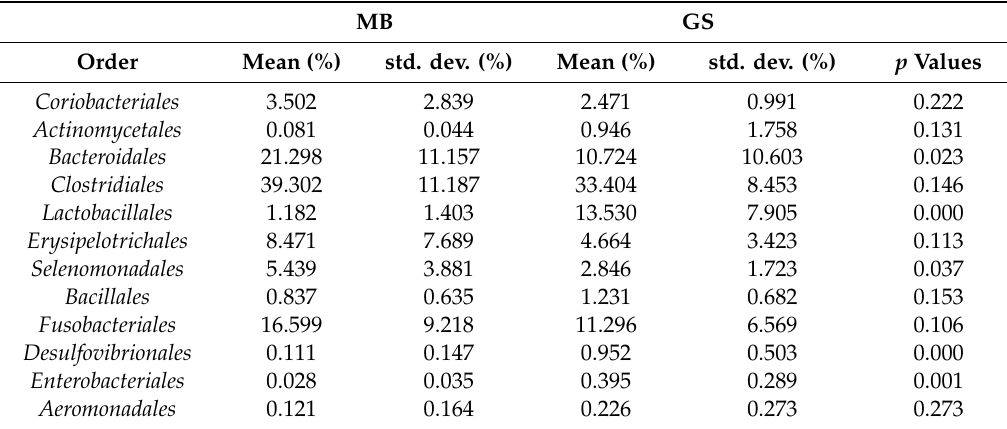
Table 3. Mean relative frequency of abundance (%) and corresponding standard deviation (SD) (%) of the orders identified in the caeca of mixed breeds (MB) and German Shepherd (GS) dogs. The species indicated are those showing a mean relative frequency of abundance ≥ 0.1% in at least one group. p values in bold are those significantly di ff erent.